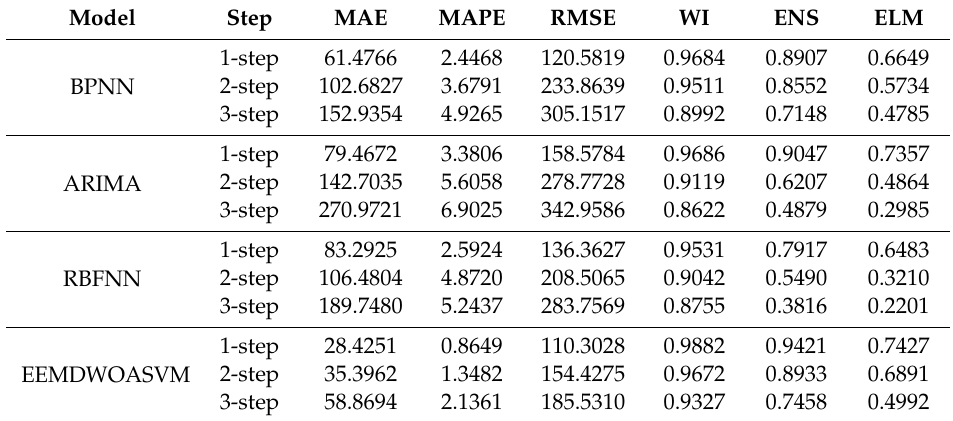
Table 4. Forecasting results of the proposed model and some traditional models using 30 min electric load data from New South Wales.